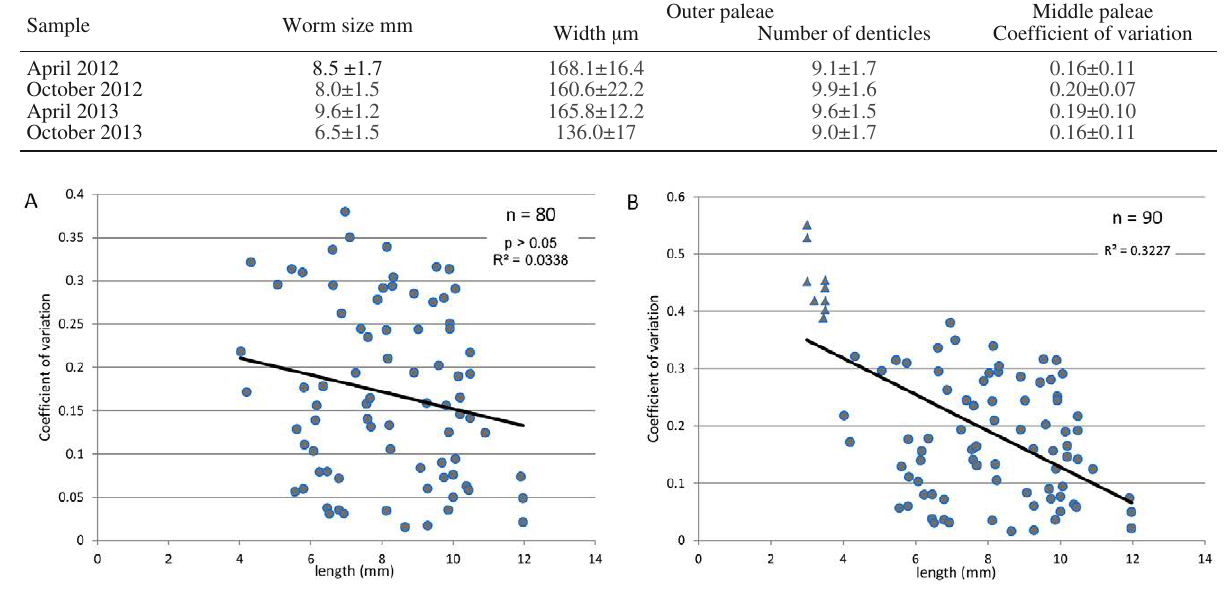
Fig. 4. – Sabellaria spinulosa. Relationship between coefficient of variation and worm length: A, field population; B, combined data from laboratory settlers and field